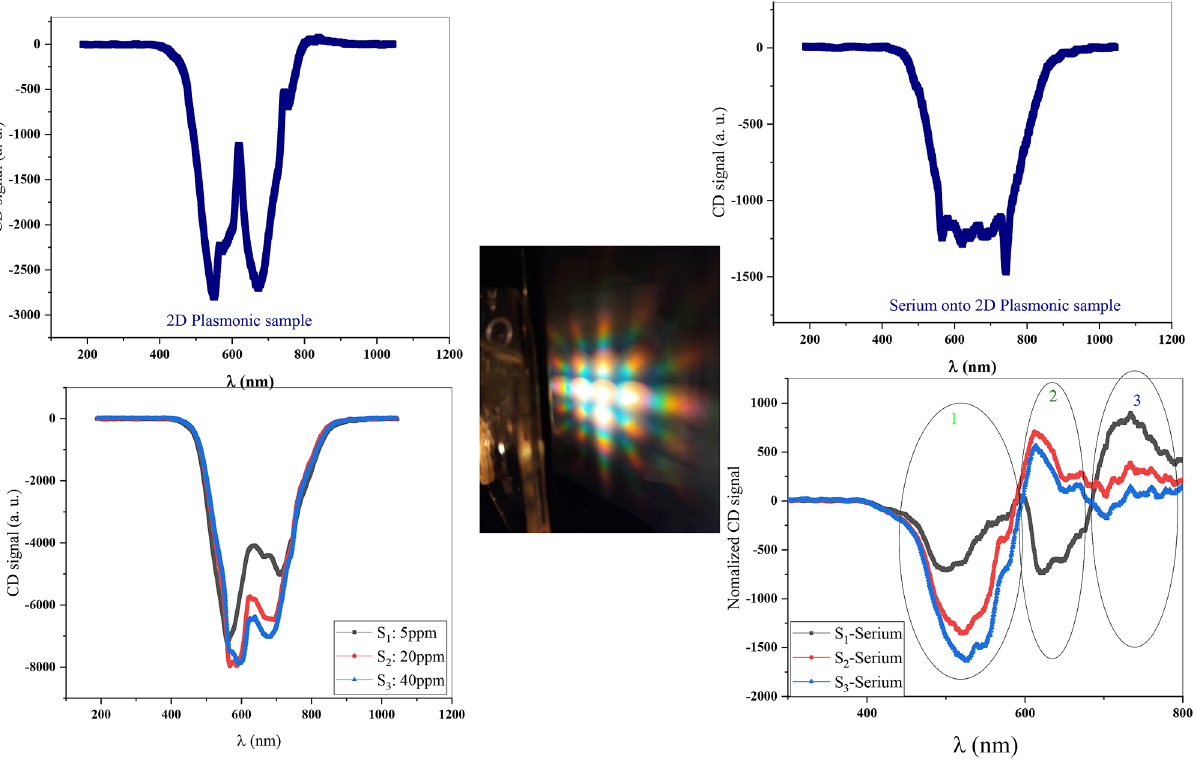
Figure 2. CD signal of ( a ) bare 2D plasmonic sample, ( b ) 2D plasmonic sample as serium sensor, ( c ) 2D plasmonic sample as Venom senor in three different concentrations and ( d ) normalized CD signal or three different venom